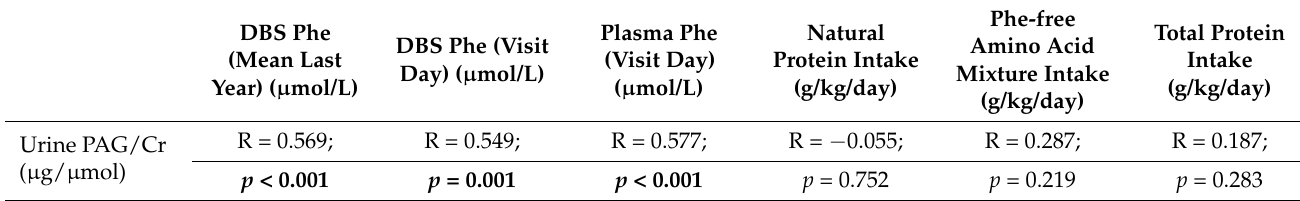
Table 3. Correlation analysis between urine PAG/Cr and phenylalanine levels and dietary protein intake in participants with